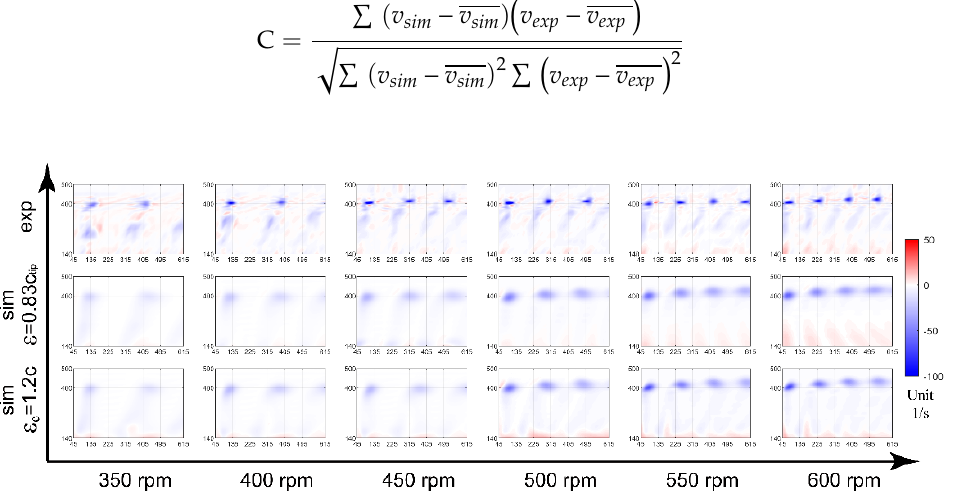
Figure 20. The vorticity magnitude contour of the plane along with the main flow. The origin is the rotor center. The data area is from 45 mm to 615 mm behind the rotor and 140 mm to 500 mm away from the main shaft.